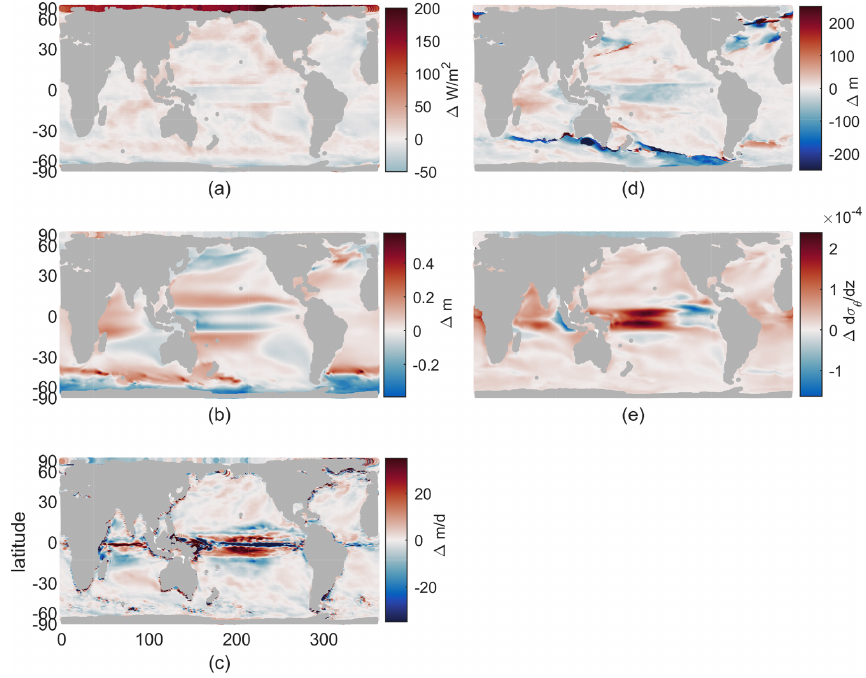
Figure 1. Climate perturbation. (a) Change in maximum incoming short-wave radiation. (b) Change in annual-mean sea surface height (SSH). (c) Change in annual-mean vertical velocity at 100m. (d) Change in annual maximum mixed-layer depth (MLD). (e) Change in annual-mean stratification at 100m, d σ θ / d z , using 155 and 55m potential density. All maps use a cylindrical equal-area